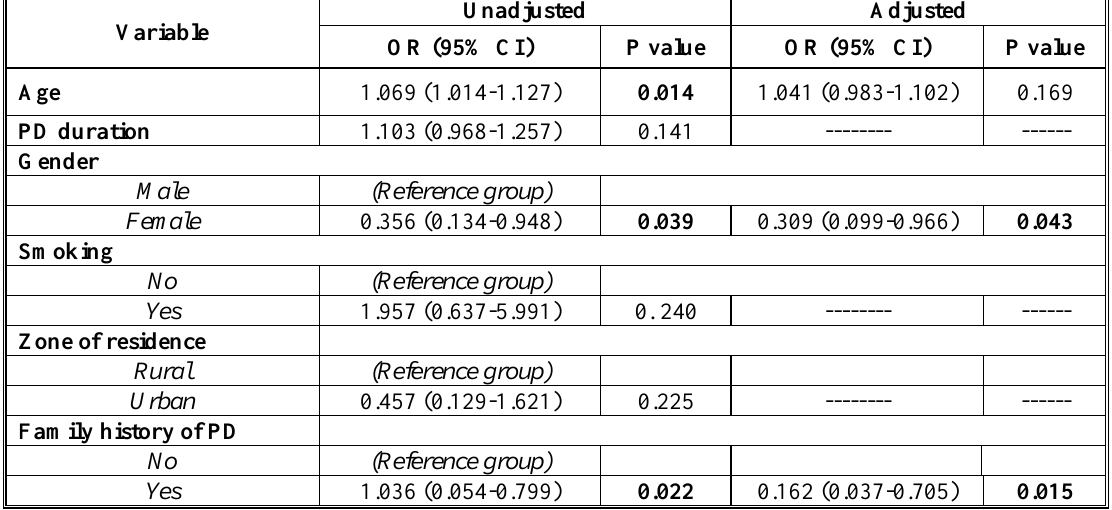
Table 4.Multiple logistic regression analysis to predict potential independent risk factors for prevalence of toxoplasmosis in Pakinson’s disease patients